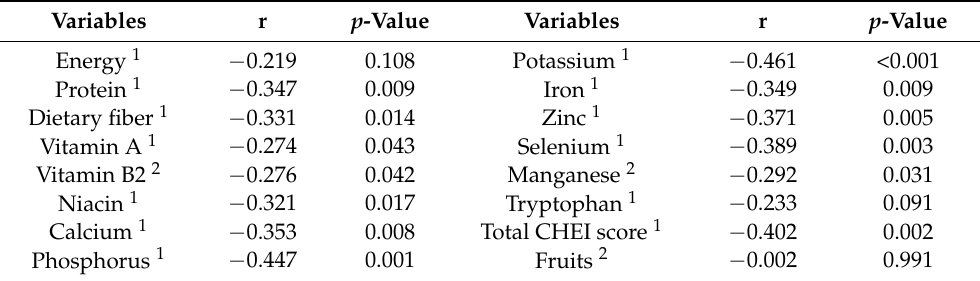
Table 2. Correlation between the CES-D score and nutrient intakes and CHEI component scores ( n = 55).